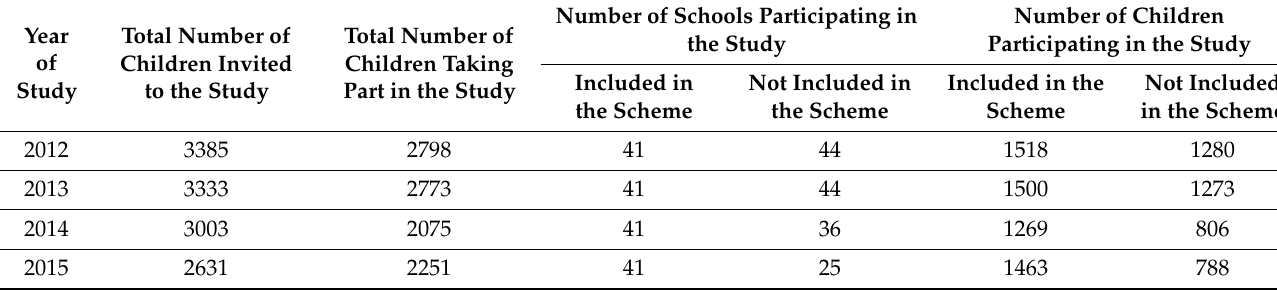
Table 1. Changes in the sample size of children taking part in the evaluation study in the years